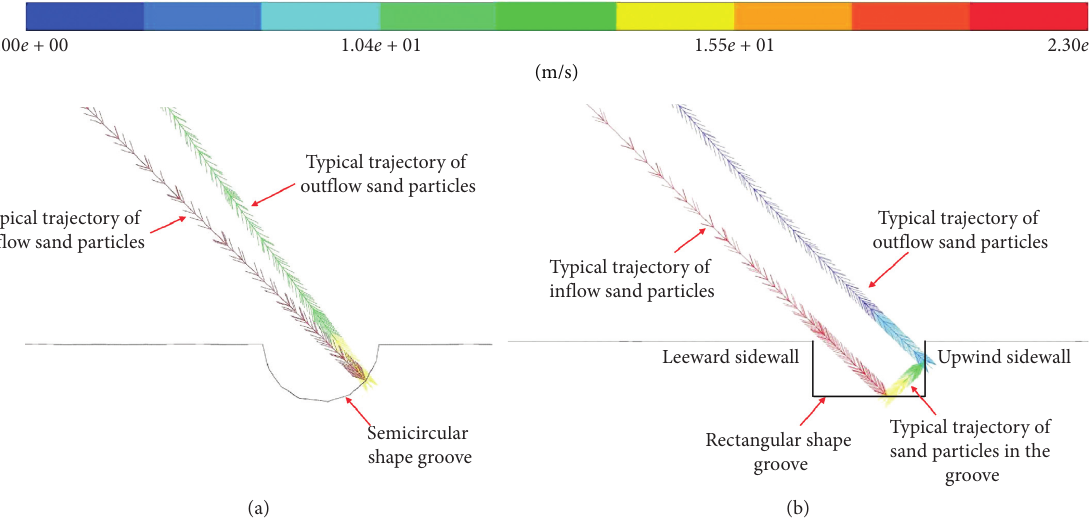
Figure 9: Typical trajectories of sand particles interaction with two different grooved concrete wall surfaces at the impact angle of 45 ° and wind velocity of 23 m/s: (a) semicircular shape groove; (b) rectangular shape groove.